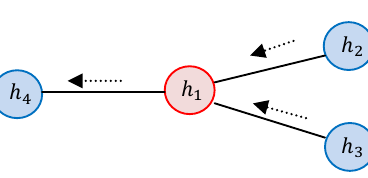
Figure 3. Four nodes in a graph connected by edges. The arrows denote the flow direction of the water, determined on the basis of the heights at the junction points. For node 1 the first criterion is fulfilled: It has one neighbour with a lower height